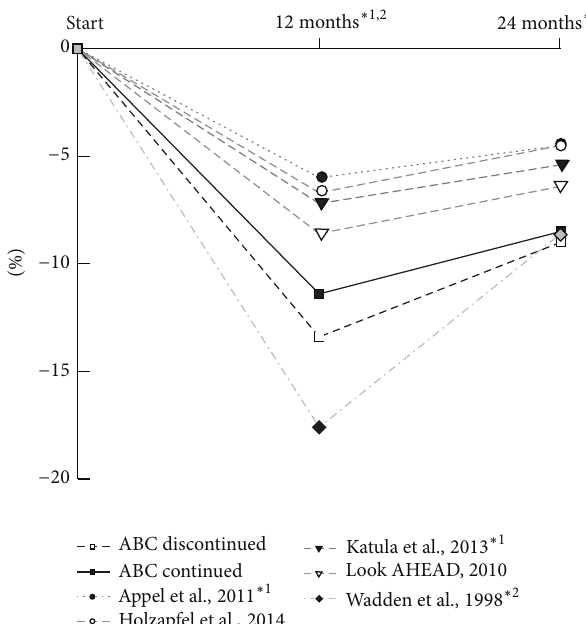
Figure 2: Comparison of weight-reduction data after 12 and 24 months in seven long-term studies including the present study. Only those studies are shown in which a minimum weight loss of 5% of the initial body weight was achieved after 12 months. ∗1 Appel et al. and Katula et al.: weight measures at 6 and 24 months. ∗2 Wadden et al.: weight measures at 48 and 100